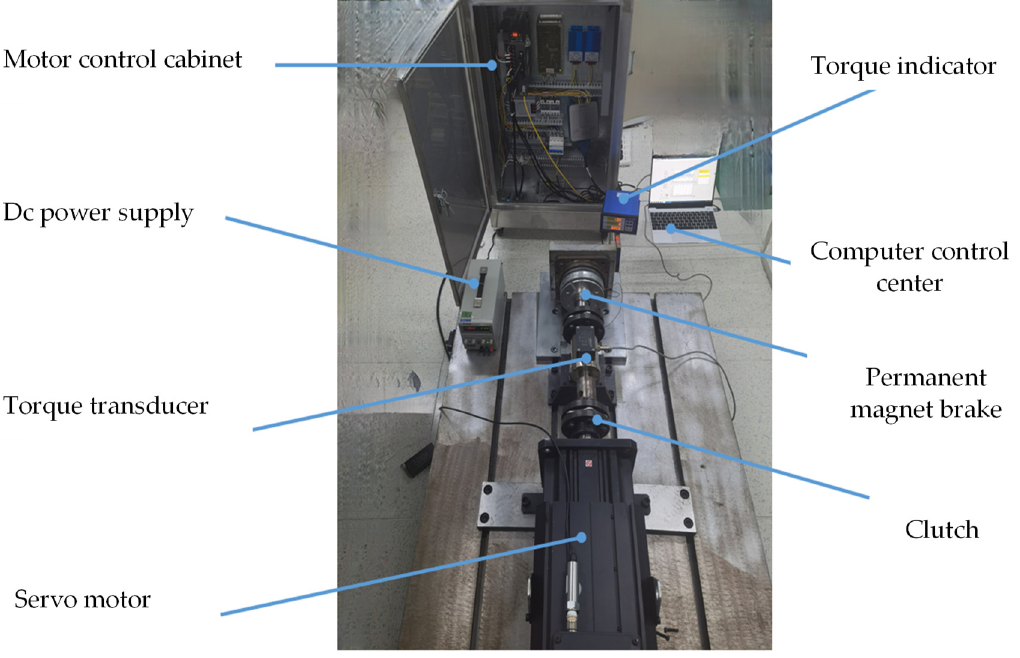
Figure 15. Torque testing platform.